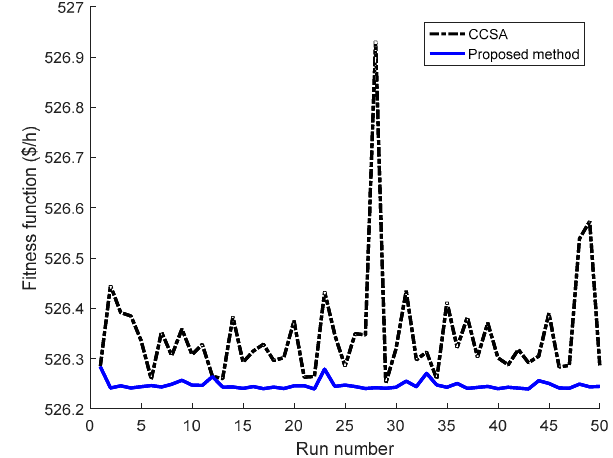
Figure 6. Fitness function of 50 runs obtained by the CCSA and proposed method in case 1.2.